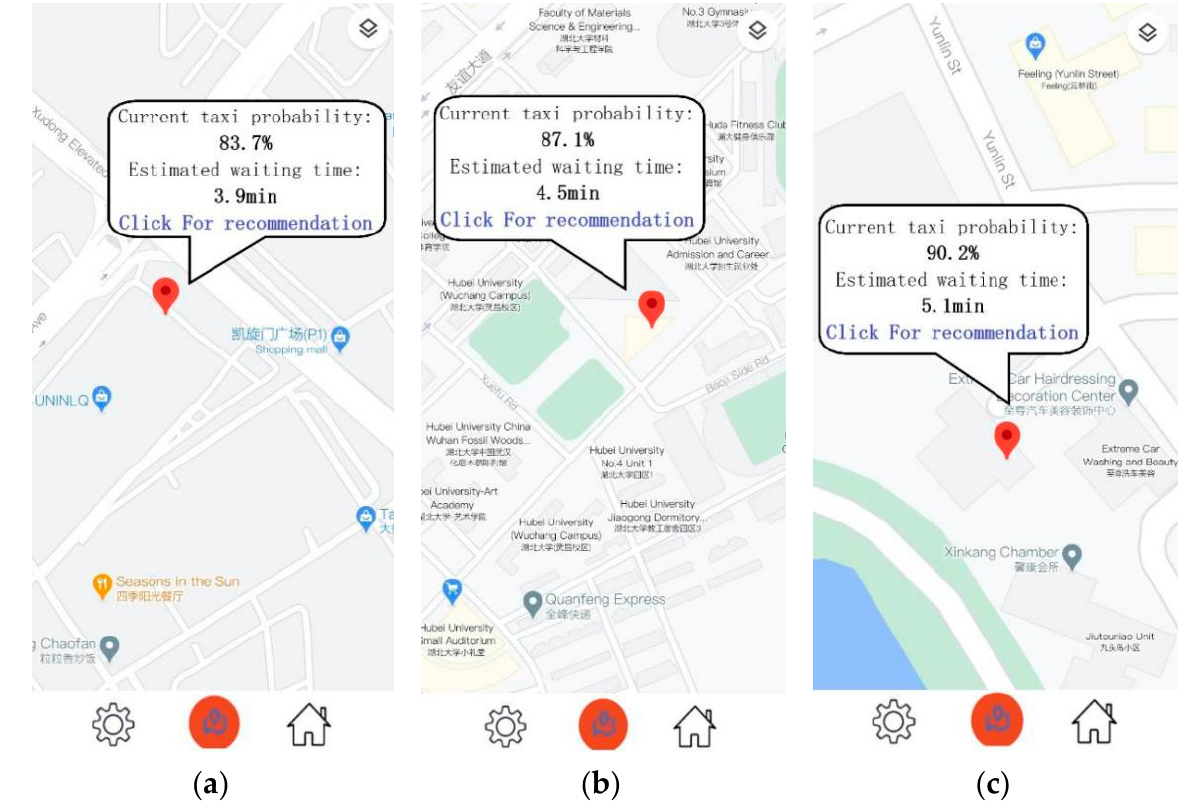
Figure 13. ( a ) Application used in front of the university at 12 noon; ( b ) application used in front of the community at 12 midnight; ( c ) application used before the mall at 3 pm.